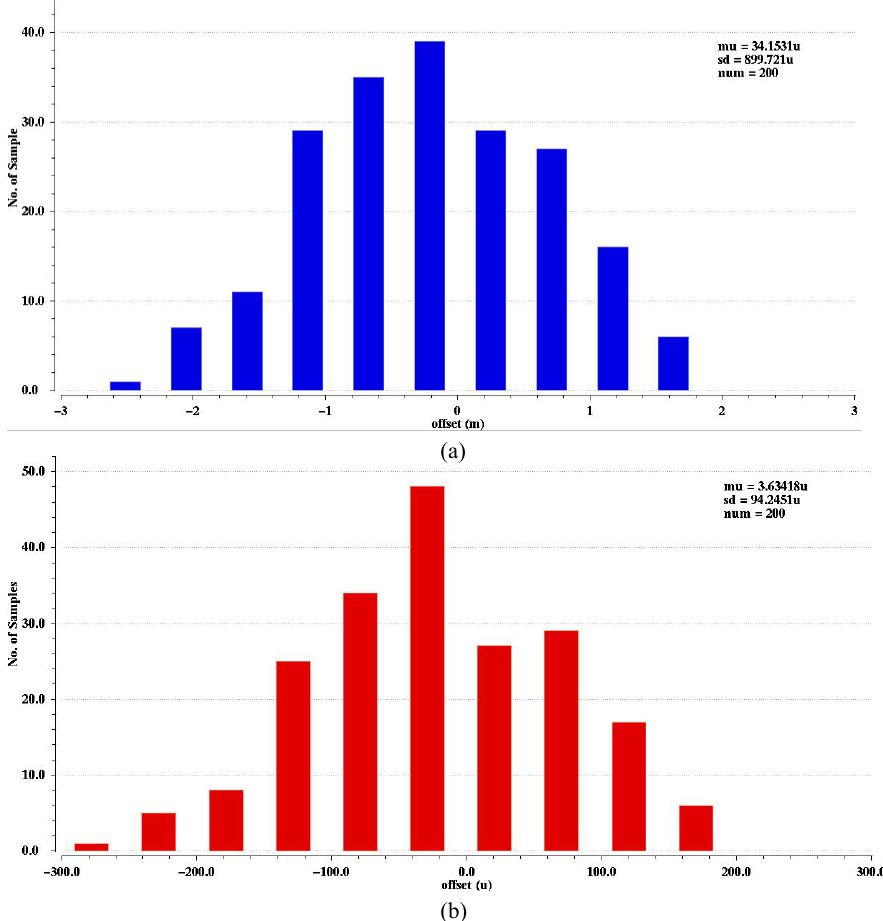
Figure 16. ( a ) Monte Carlo simulation of the first stage amplifier offset spread; ( b ) Monte Carlo simulation of the first stage amplifier offset spread after chopping.